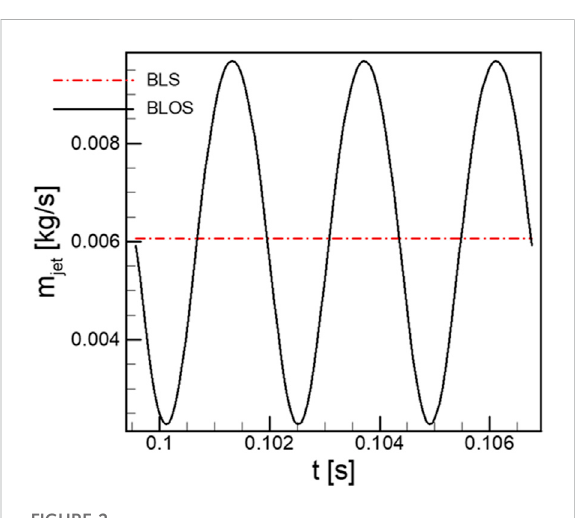
FIGURE 2 Periodic signal of the mass fl ow rate modeled by Eq. 1.